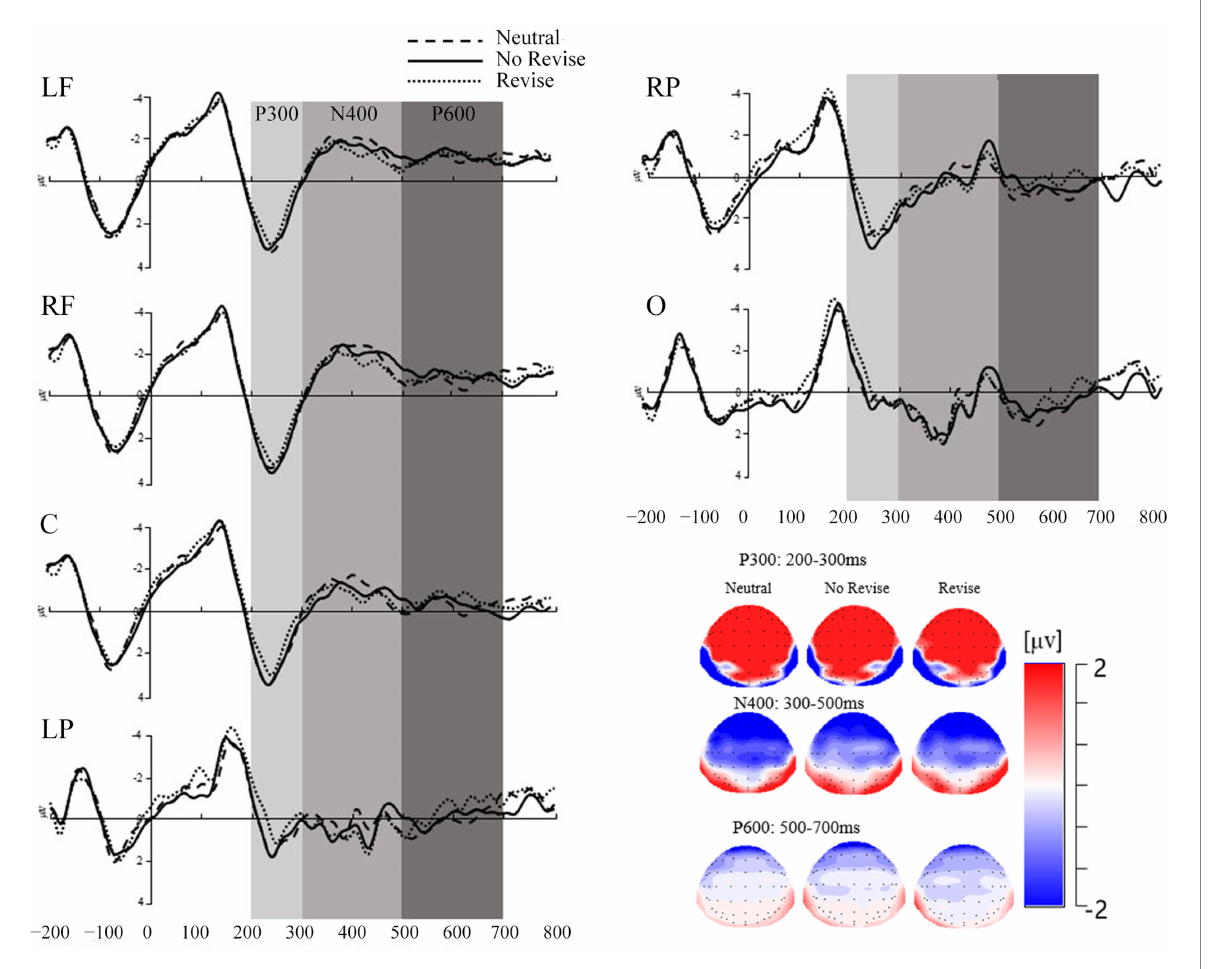
FIGURE 2 Graphical representation of the mean amplitude (in microvolts) for the P300, the N400, and the P600 components divided by contextual conditions and ROIs in Experiment